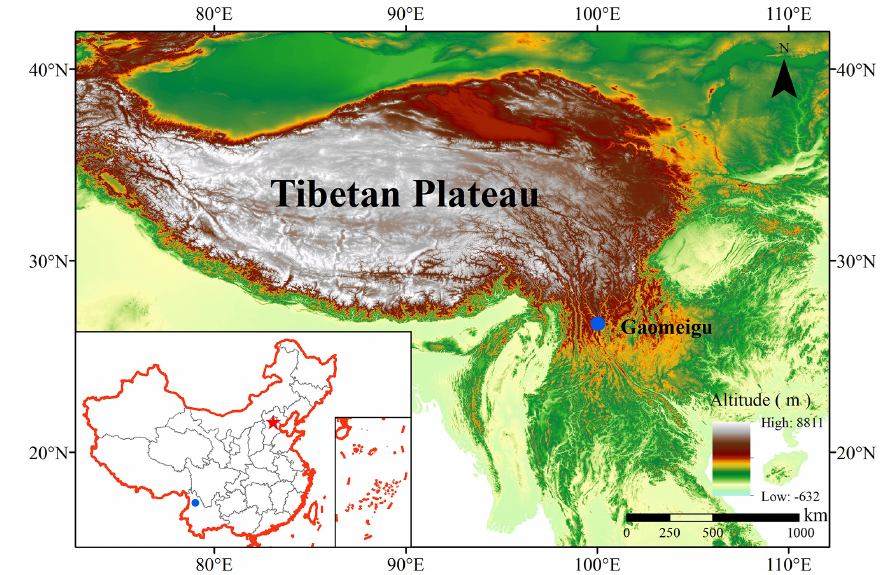
Figure 1. Topography map of the Tibetan Plateau and the location of the sampling site at